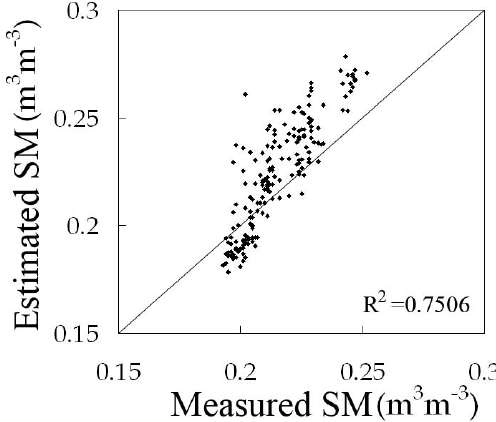
Fig. 12. The soil moisture of the upper 5cm measured in field by Stevens’ Hydra probe against the soil moisture estimated from the evaporative fraction using Eq.